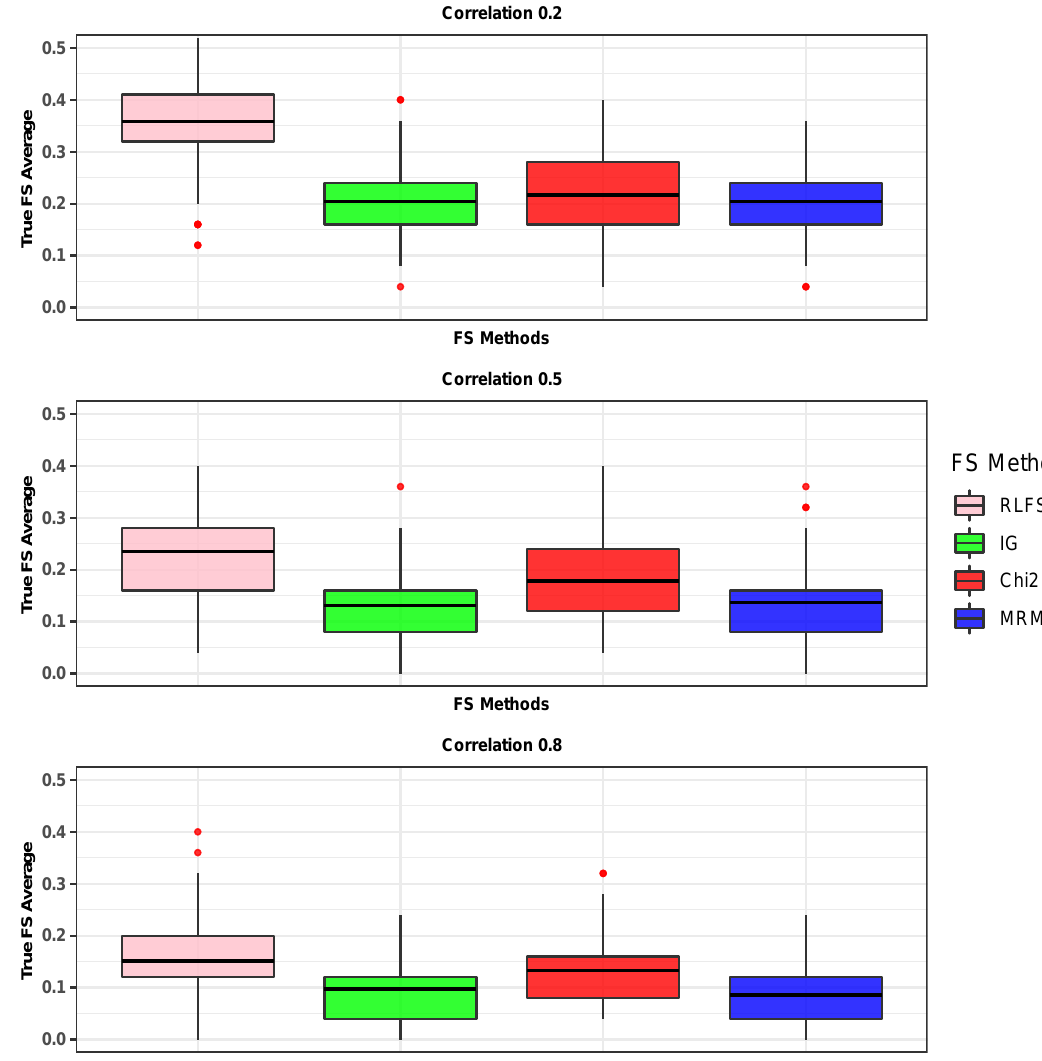
Figure 2. True number of features selected among top b -SIS ranked features, and the average of this taken over 100 iterations for three different scenarios. The first horizontal line in the box shows the first quartile and the second horizontal dark line which usually represents the median values are shown as the mean values in this article. The third horizontal line in each of the boxes shows the third quartile. The red dotted circles indicate the outliers in each of the FS